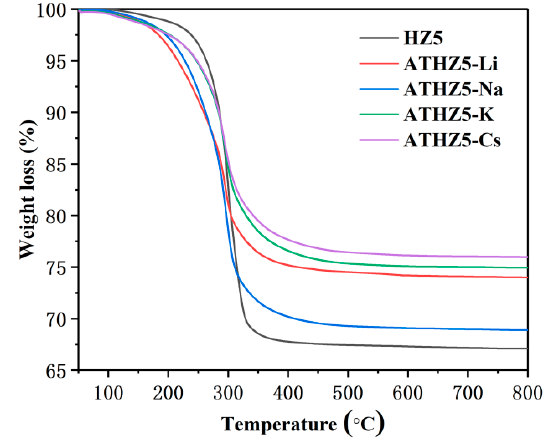
Figure 7. Thermogravimetric curves of spent catalysts after 12 h in oligomerization.